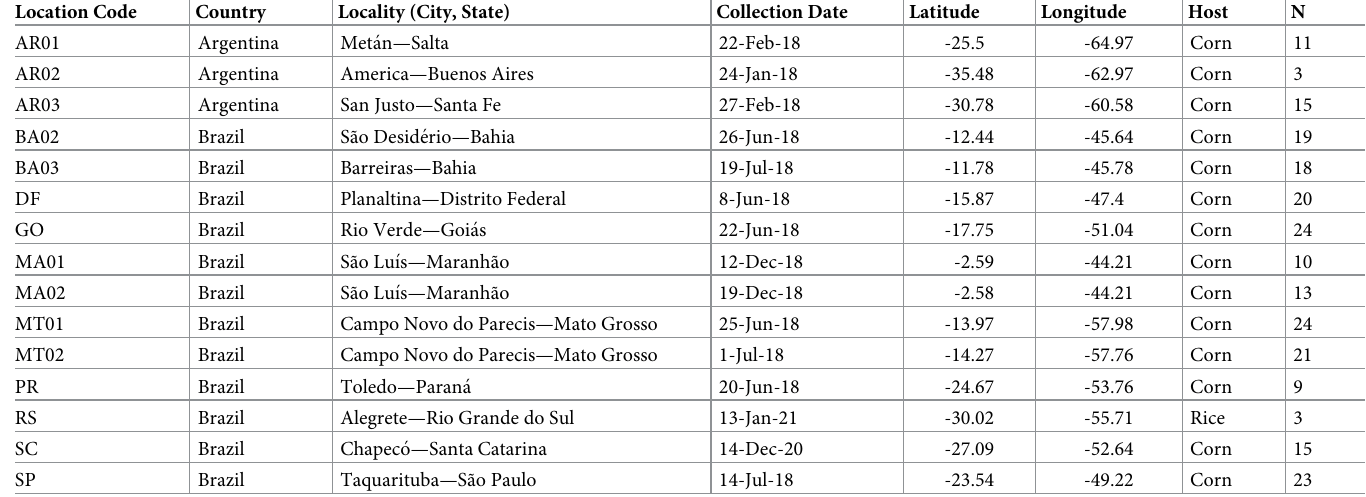
Table 1. Fall armyworm ( Spodoptera frugiperda ) sampling information. N refers to the number of samples successfully sequenced after GBS processing, totaling 228 individuals. Location